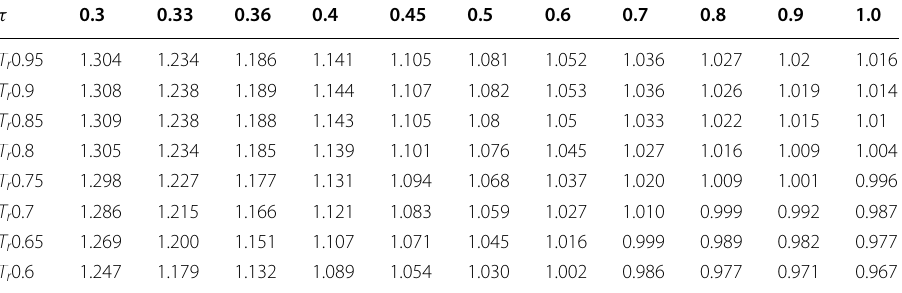
Table 1 Variation of isotropy-preserving parameter α with regard to relaxation time τ and reduced temperature T r